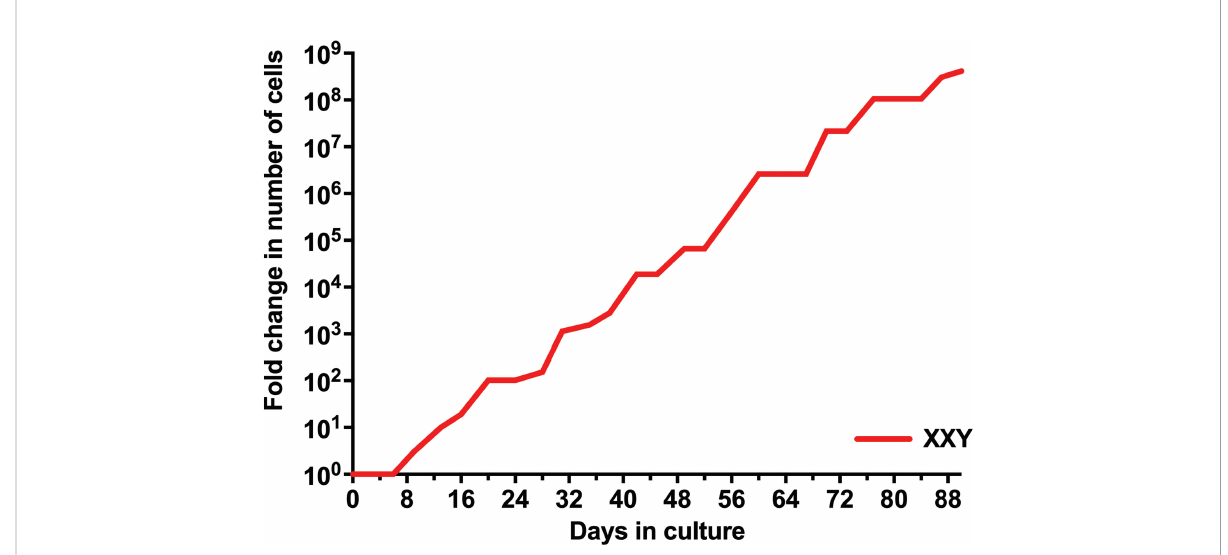
FIGURE 3 Evolution of the number of isolated human KS testicular cells in culture. Results show the average from KS subjects ’ testicular tissue. The initial number of cells was standardized to 1 to better assess growth along time in the graph and compare subjects with different initial cell